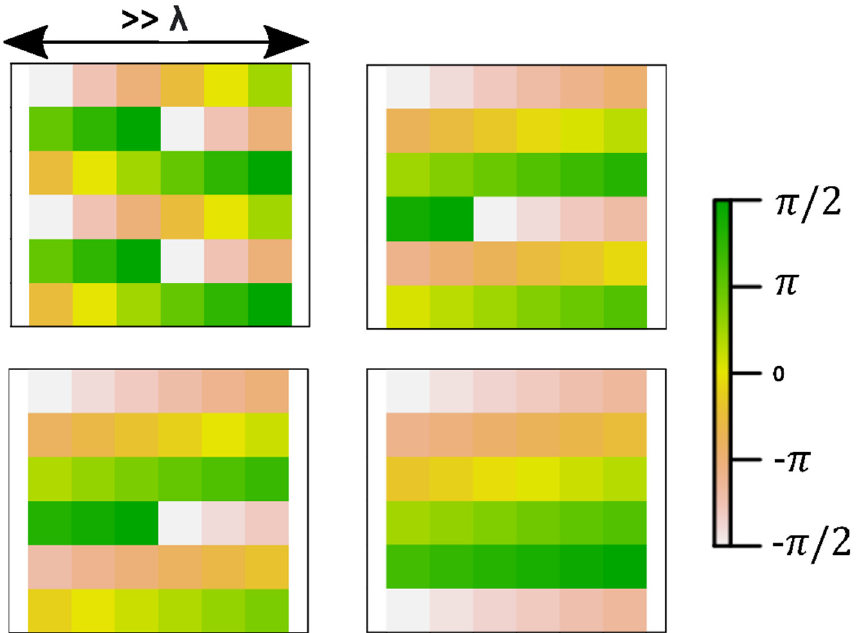
Figure 4. Reconfigurable Intelligent Surface (Metasurface): A 4-element metasurface based RIS (Each element is a dynamic meta-surface with numerous tightly packed meta-atoms and can apply an arbitrary quasi-continuous phase gradient).